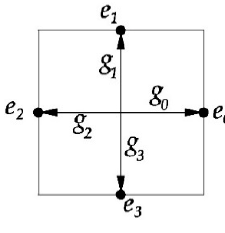
Figure 1. D2Q4 model.